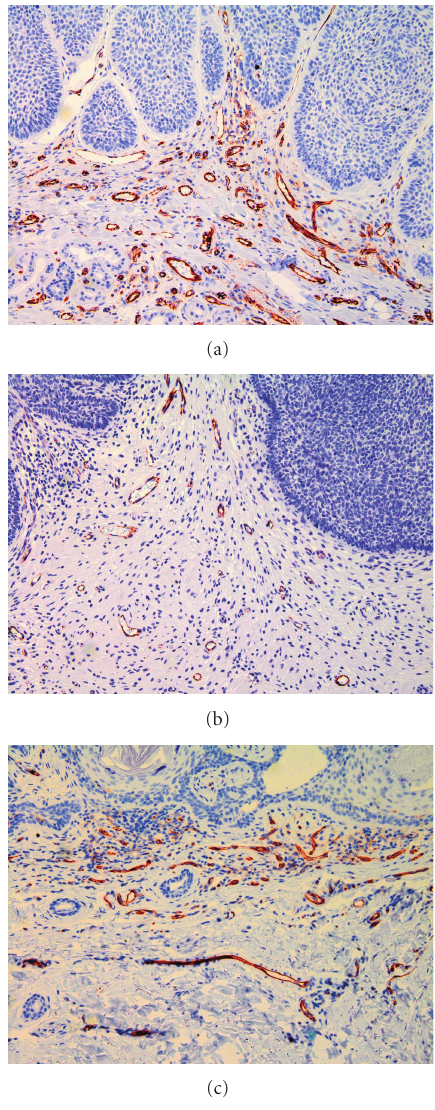
Figure 3: (a) CD 31 stained section of a nodular BCCs shows many vessels (200x magnification). (b) In a CD 31-stained section of a trichoblastoma, only a few vessels can be seen (200x magnification). (c) Microvessel density in a CD 31 stained section of a Pinkus’ tumor is on an intermediate level (200x